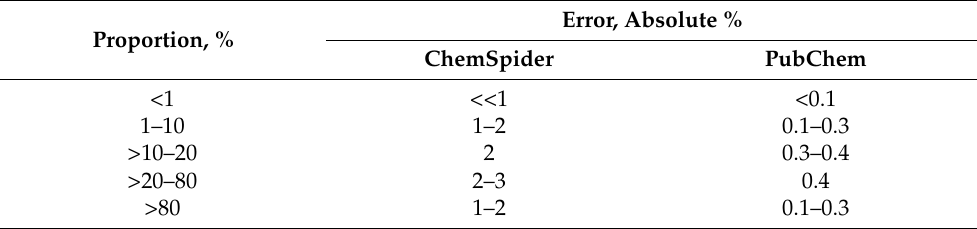
Table 2. Statistical errors in estimating one or another proportion of